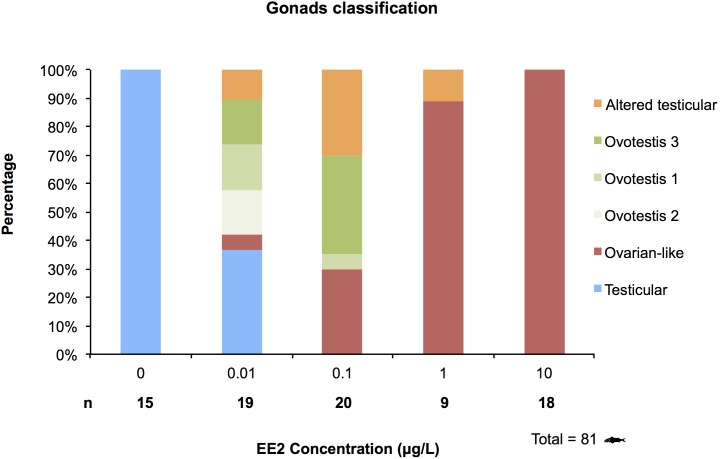
Relative frequencies of the gonad mophological forms.This graph represents the percentage of fish belonging to each morphological category, per concentration of EE2 used in the chronic experiment. n refers to the number of fish analyzed per experimental concentration.